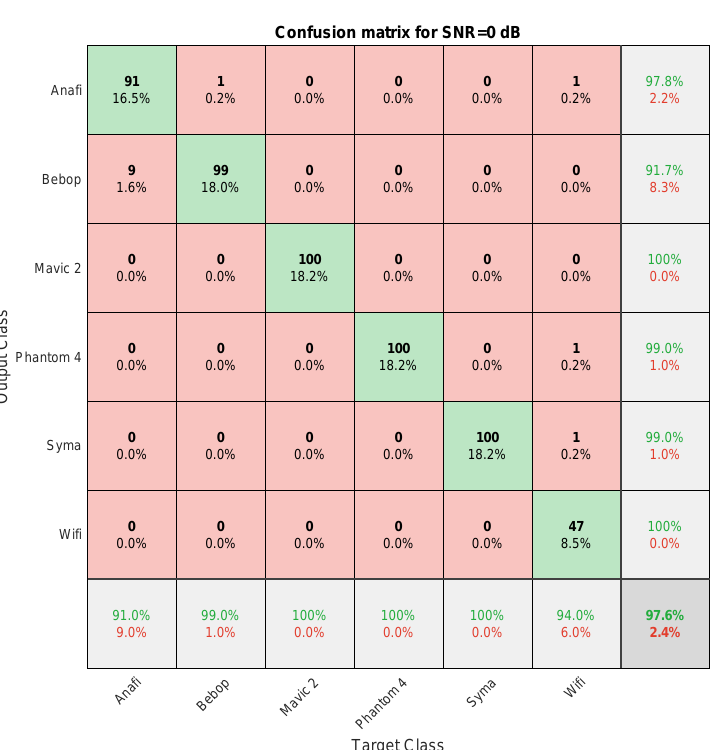
Figure 6. Classification rate against SNR.